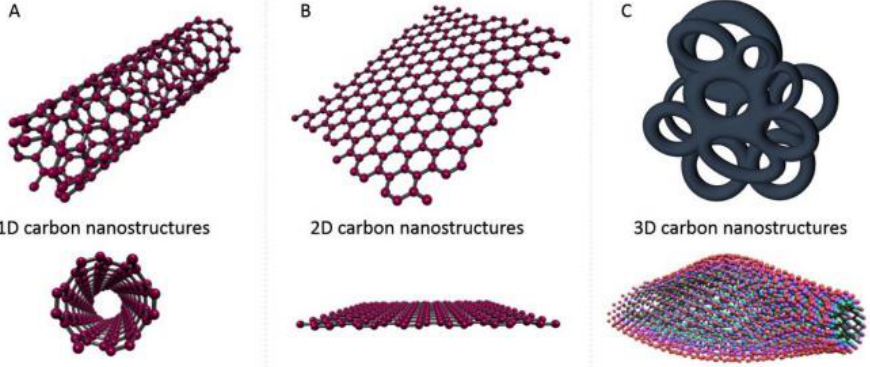
Figure 12. Illustration of the fundamental carbon nanostructures: ( A ) 1D carbon nanostructure (1D CNTs and CFs), ( B ) 2D nanostructure (graphene, graphite nanoplates, EG, and GO), and ( C ) 3D nanostructure (carbon foam, and graphite/graphene foams and aerogels) [146].